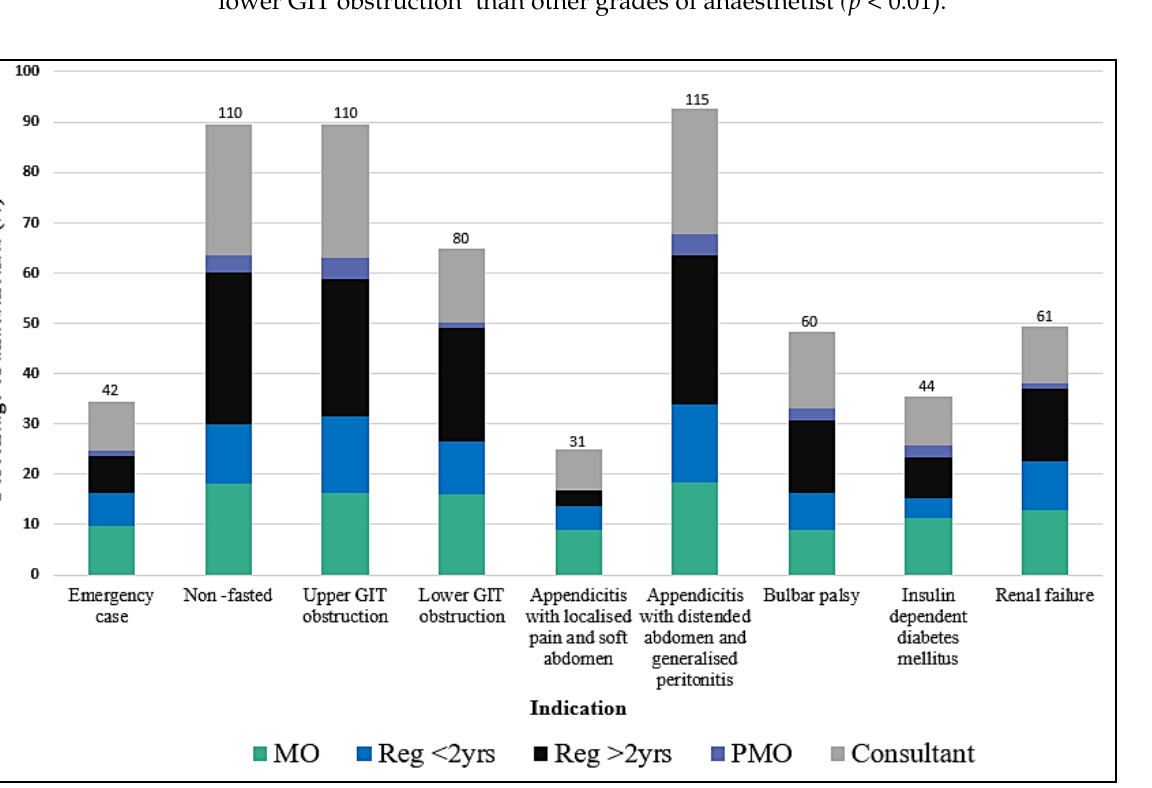
Figure 1. Indications for RSI technique by grade of anaesthetist.